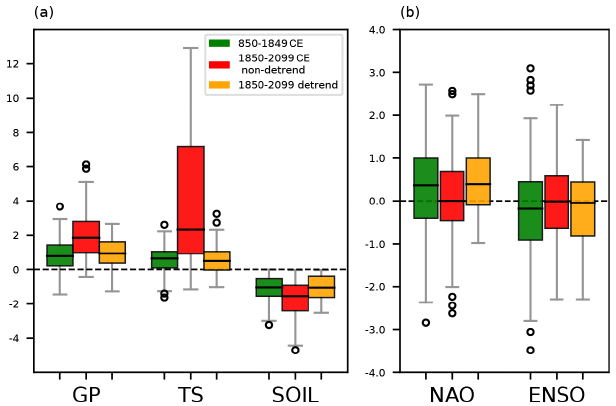
Figure 14. (a) Standardized regional variables: anomalies of geopotential height at 850hPa (GP), surface temperature (TS), and soil moisture (SOIL) over the region of study. (b) Indices of large- scale circulation patterns: NAO and ENSO during Mediterranean droughts for the period of 850–1849CE (green), non-detrended 1850–2099CE (red), and detrended 1850–2099CE (yellow). The GP, TS, and SOIL between the detrended 1850–2099CE and the 850–1849CE periods present p values from the Mann–Whitney U tests of 0.09, 0.02, and 0.29, respectively. For NAO and ENSO, the p values between these two periods are 0.19 and 0.29, respec-